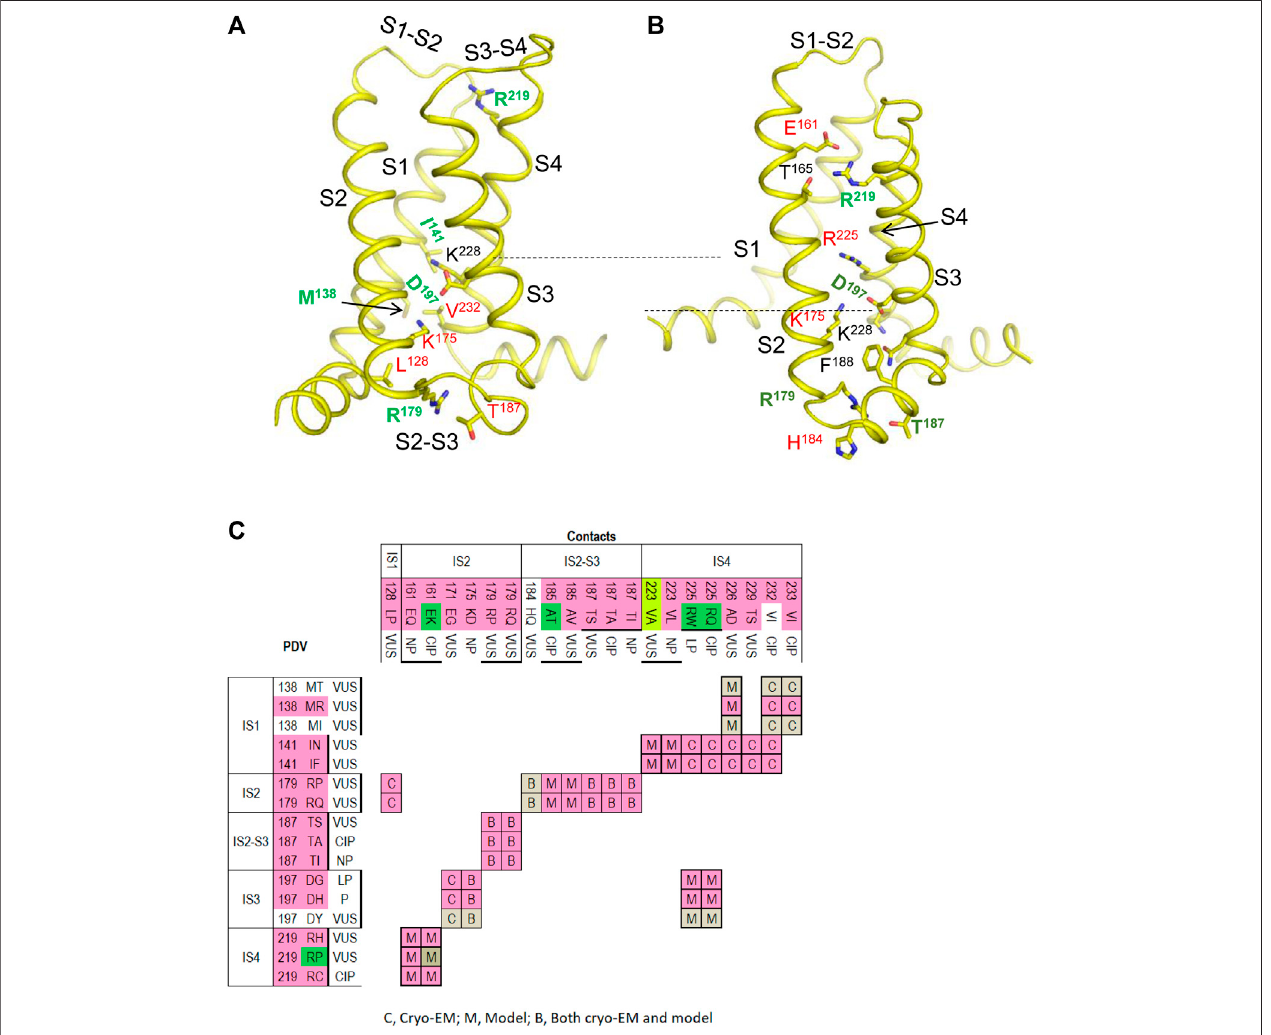
FIGURE 5 | VSD-I in the activated-state structure and resting-state model. (A,B) Intra-membrane views at VSD-I in the activated (A) and resting (B) states. Side chainsofsomew54residuesandtheircontactsareindicatedwithgreenandredlabels,respectively.DashedlinesindicatedisplacementofK 228 uponactivationofVSD- I. (C) Matrix ofcontacts variants. Toindicate contacts, which may switch upon activationofVSD-I,each cell islabeled “ C ” , “ M ” or “ B ” depending onwhether thecontact is found only in the cryo-EM structure, only in the resting-state model, or both in the cryo-EM structure and the model. Overwhelming majority of PDVs and their contact variants are associated with BrS1. See section VSD-I for more